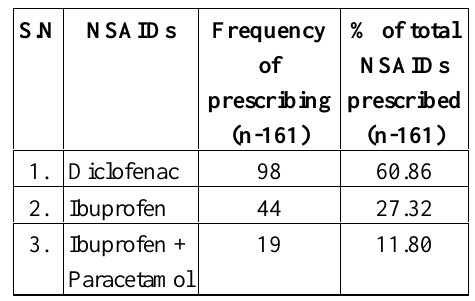
Table VI. Pattern of Prescribing of